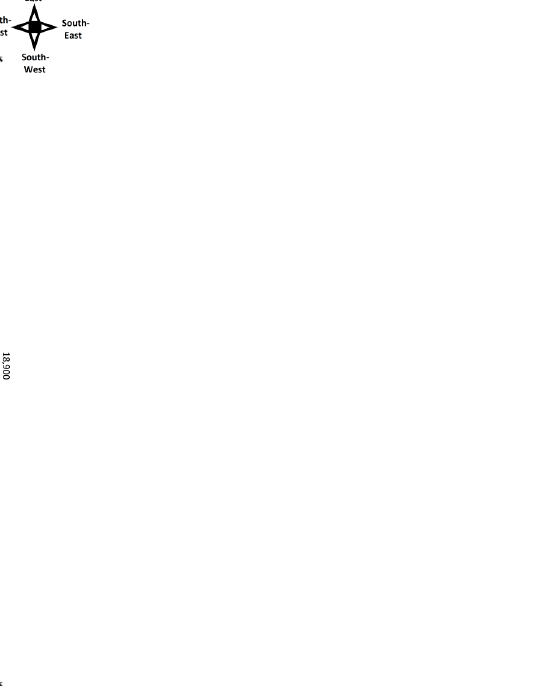
Figure 4. The cross ‐ section of the living room’s wall and floor construction after renovation in 2015.